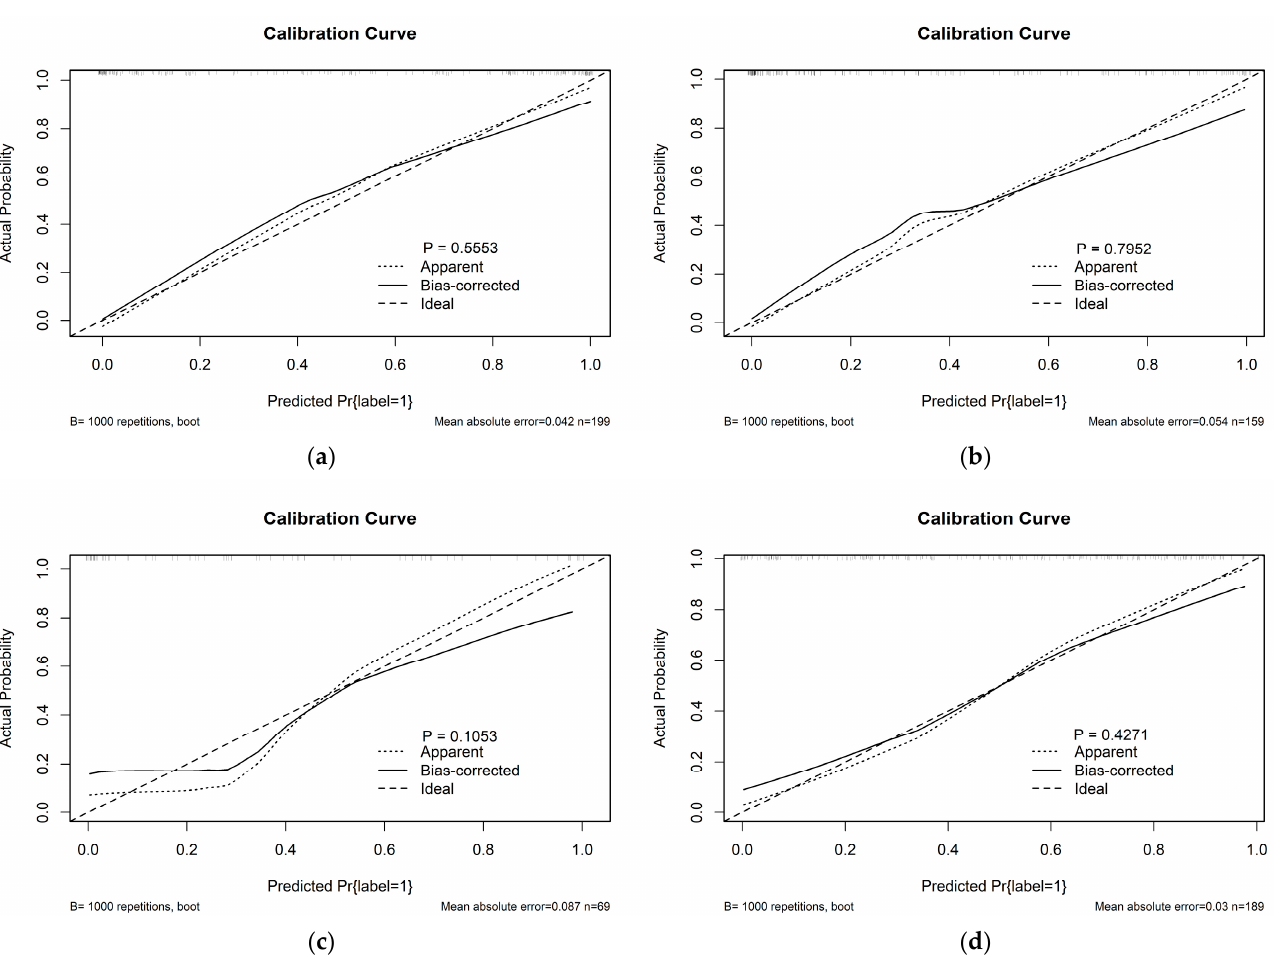
Figure 6. Calibration curves of the radiomic model in ( a ) the SMOTE training cohort; ( b ) the un- SMOTE training cohort; ( c ) the test cohort and ( d ) the independent TCGA/TCIA validation cohort, and their corresponding p values.